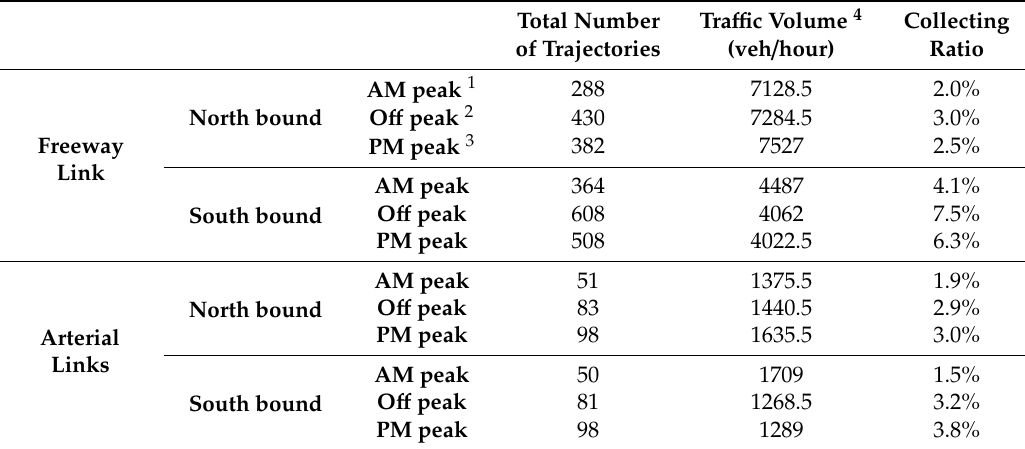
Table 1. Acquired vehicle trajectories.